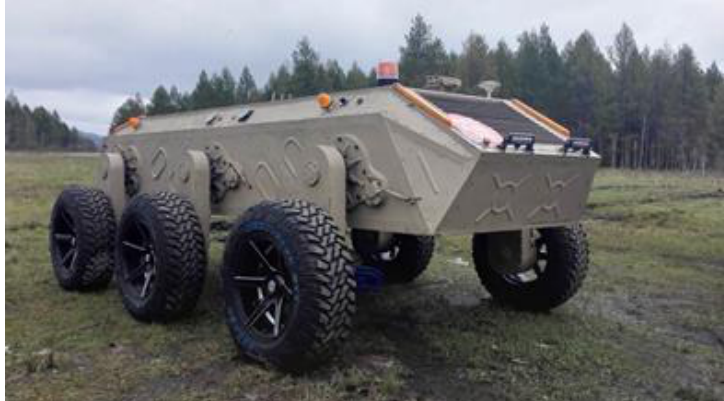
Figure 10. Experimental platform. Table 1. Essential parameters of the platform.